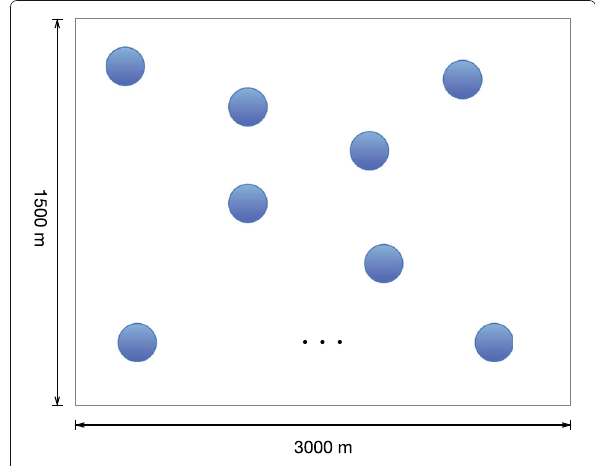
Fig. 9 End-to-end delay in the chain topology the binary search will stop when APR is in the range of 1.29–2.15 in the fifth iteration. The iterations are shown in Table 1.